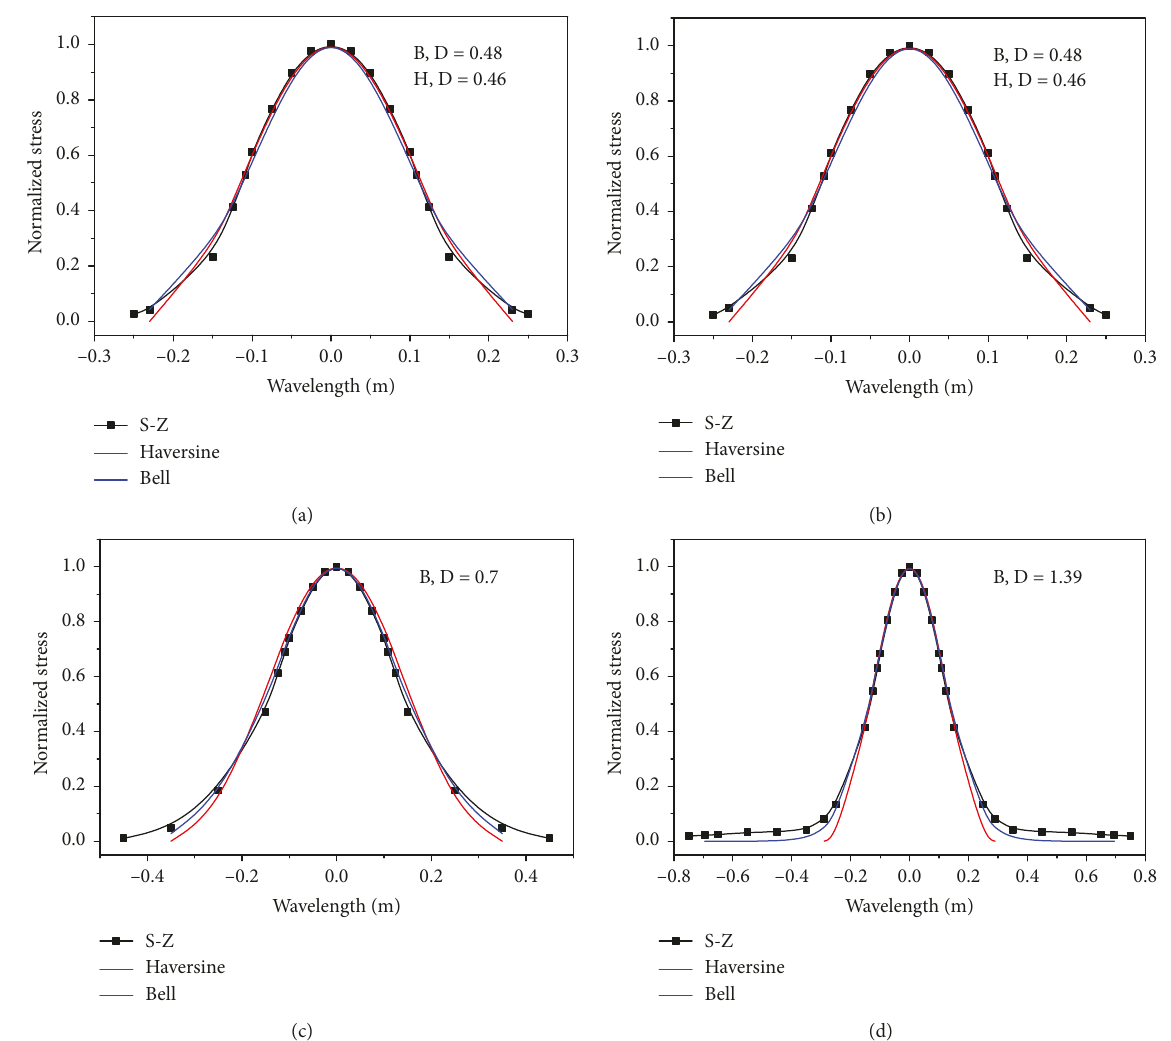
Figure 4: Vertical compressive stress pulse with different pavement structures: (a) R � 0.5, Z � 10cm; (b) R � 0.5, Z � 10cm; (c) R � 1, Z � 20cm; (d) R � 20, Z �